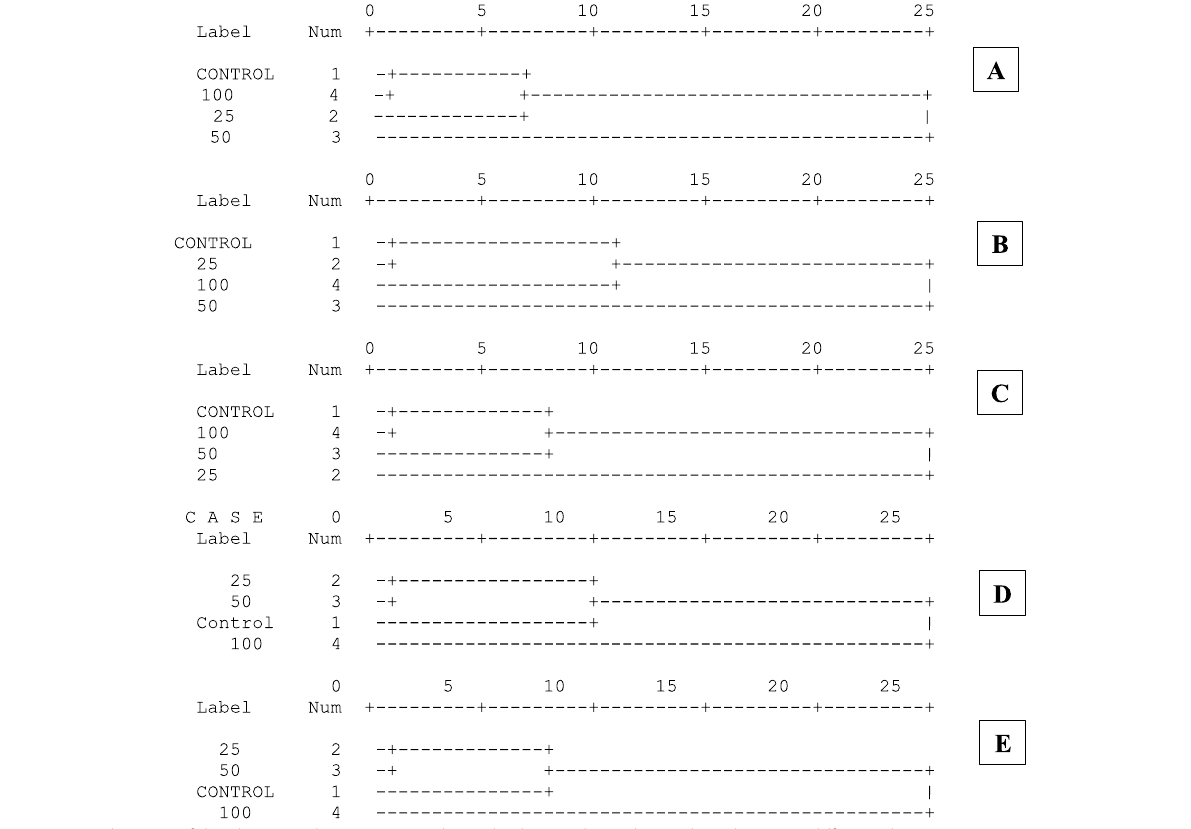
Fig. 4 Dendrogram of the cluster analysis (using Ward’s method) to evaluate the similarity between different clonazepam concentrations (25, 50, or 100 mg/ml), which has been fed to the developmental stages (second, early third, and late third larval instars and prepupa) of Sarcophaga argyrostoma , and the ( A ) weight (mg), B length (mm), C width (mm), D concentration of clonazepam (mg/ml) in insect’s tissues using HPLC–MS, and ( E ) protein carbonyls amount in insect’s tissues using (OD/ mg protein/